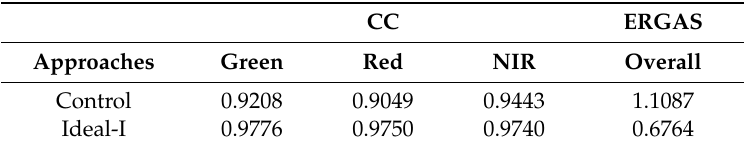
Figure 12. Changes of relative average absolute difference (RAAD) with respect to standard deviation (SD) of reflectance from Landsat pixels within each MODIS pixel for ( a – c ) Boreal data and ( d – f ) Panyu data. Table 5. CC and ERGAS of the fusion results applied to the Panyu images for both control and Ideal-I cases.